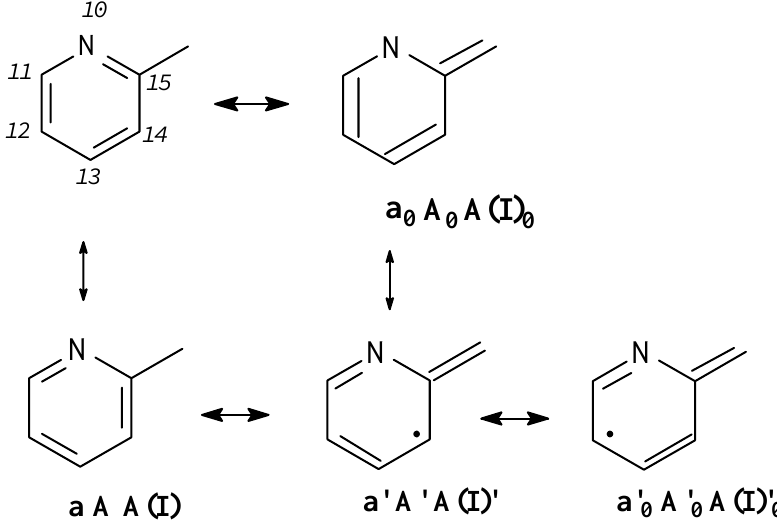
Figure 7 . The resonance structures of the pyridyl